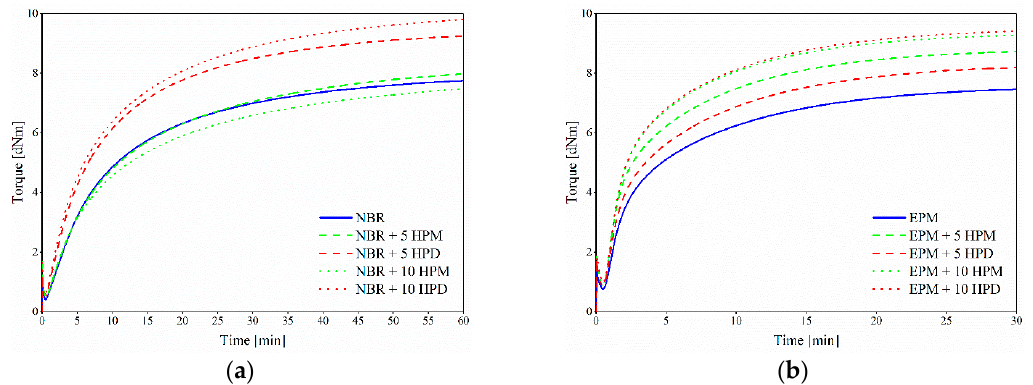
Figure 8. Curing curves for ( a ) NBR and ( b ) EPM compounds filled with hybrid pigments. Table 4. Curing parameters of NBR and EPM